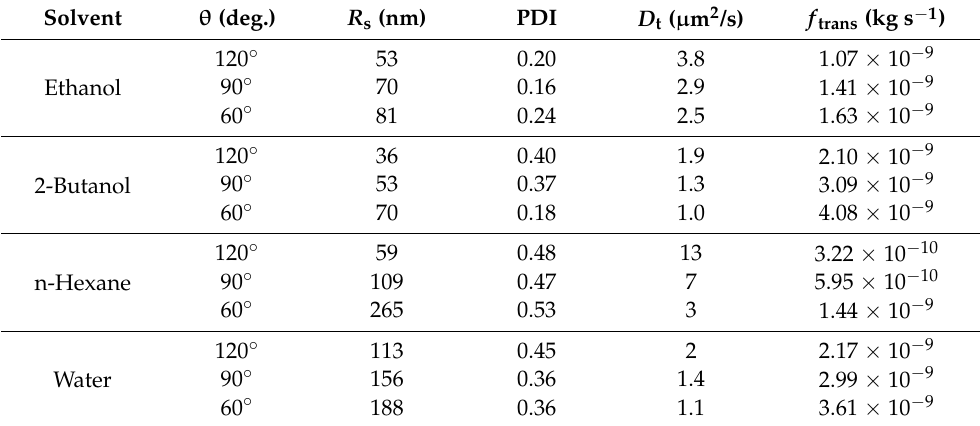
Table 2. Summary of evaluated hydrodynamic results of femtosecond-laser-synthesized colloidal